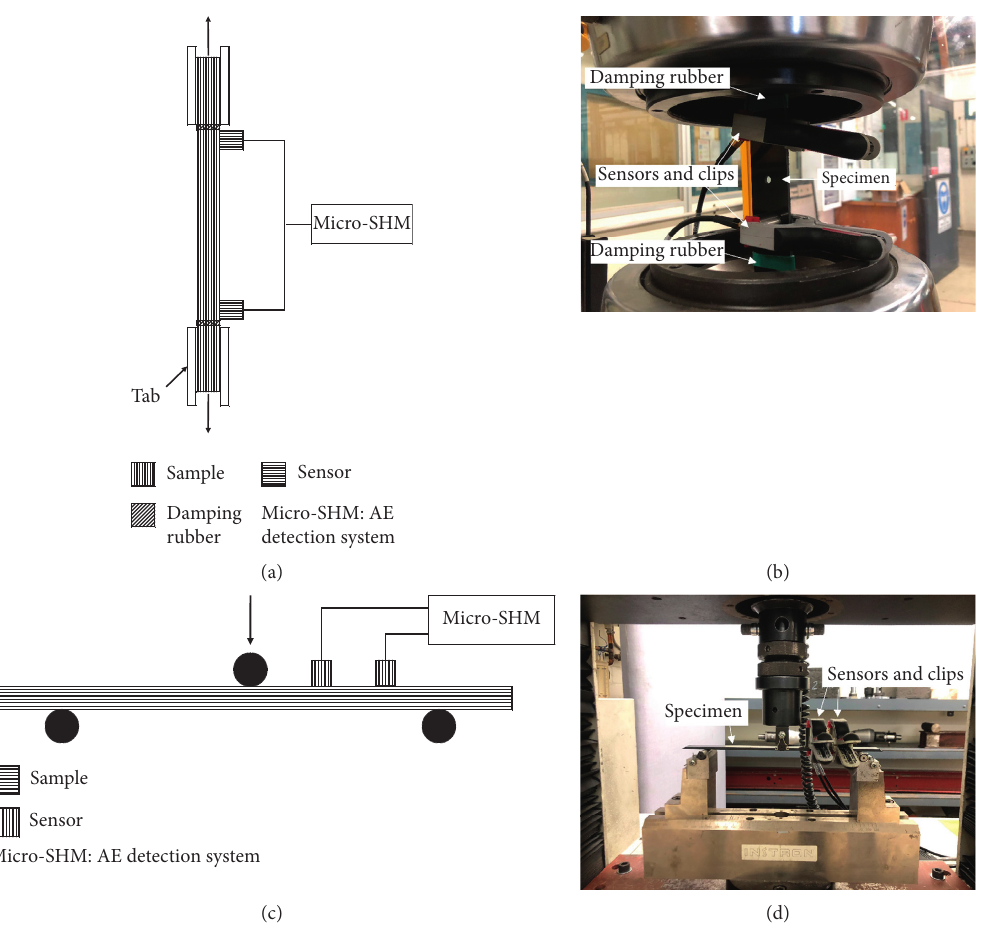
Figure 3: Experiment equipment. (a) Schematic graph of the tensile test setup. (b) Picture of the tensile test setup. (c) Schematic graph of the bending test setup. (d) Picture of the bending test setup.